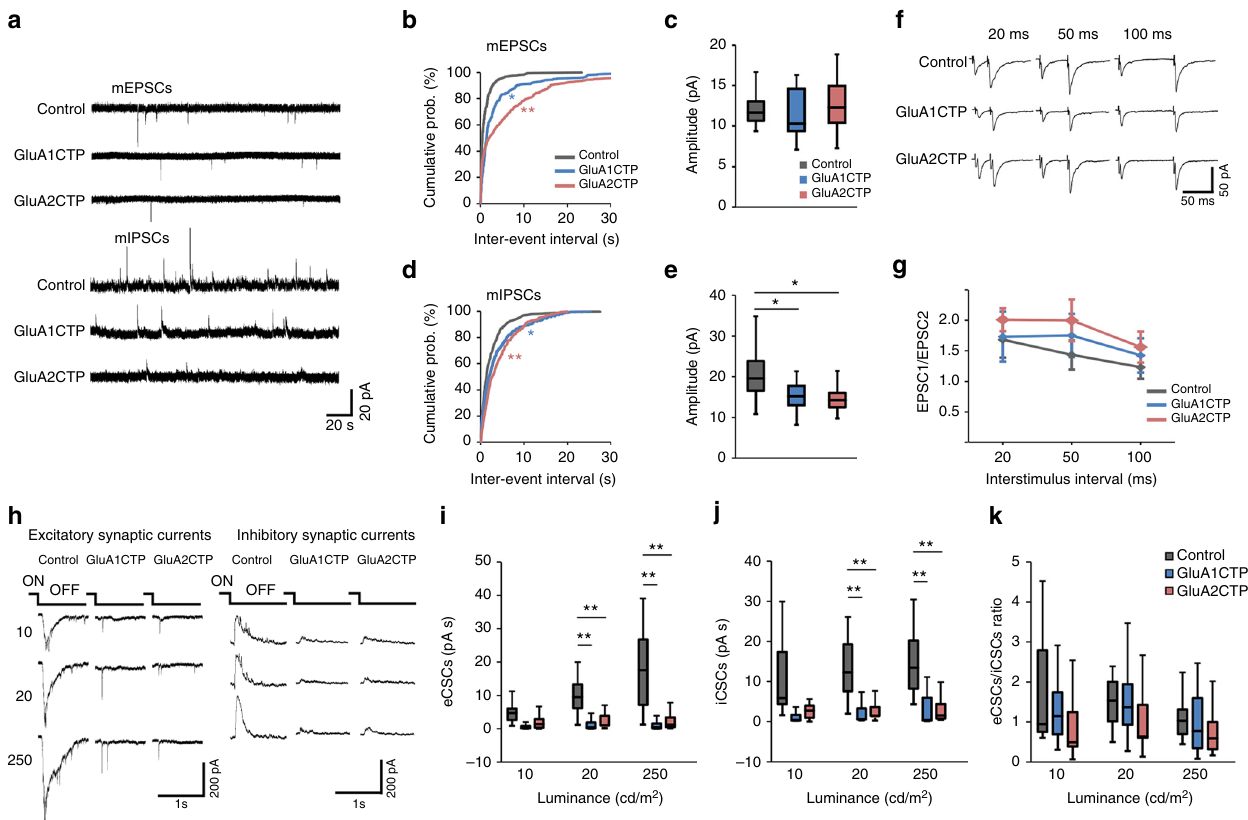
Fig. 1 GluACTP expression reduced both spontaneous and evoked excitatory and inhibitory synaptic transmission in tectal neurons. a Representative traces of mEPSCs and mIPSCs from neurons expressing EGFP only (Control), GluA1CTP, and GluA2CTP, respectively. b Expression of GluA1CTP or GluA2CTP signi fi cantly increased inter-event intervals (IEIs) of mEPSCs in tectal neurons. * P < 0.05, ** P < 0.01. Kolmogorov – Smirnov test. c Amplitudes of mEPSCs were not signi fi cantly affected by GluA1CTP or GluA2CTP expression. Control: n = 14; GluA1CTP: n = 13; GluA2CTP: n = 15. d, e Cumulative distributions ( d ) and amplitudes ( e ) of mIPSCs showing GluA1CTP or GluA2CTP expression signi fi cantly increased IEI and decreased amplitudes of mIPSCs compared to control neurons. * P < 0.05, ** P < 0.01. Kolmogorov – Smirnov test or ANOVA with Newman – Keuls posthoc test. f Representative recordings of EPSCs in response to paired stimuli 20, 50, and 100 ms apart from neurons in each experimental group. Stimulus artifact was clipped for clarity. g Paired pulse ratios of EPSC2/EPSC1 were not signi fi cantly different between control, GluA1CTP-, and GluA2CTP-expressing neurons. Scale bar: 20 pA, 20 ms. Control: n = 7; GluA1CTP: n = 5; GluA2CTP: n = 5. h Representative traces for visually evoked excitatory CSCs (eCSCs) and inhibitory CSCs (iCSCs) in control, GluA1CTP-, and GluA2CTP-expressing neurons in response to full- fi eld light off visual stimuli at intensities of 10, 20, and 250 cd cm − 2 . i , j Summary data showing that eCSCs ( i ) and iCSCs ( j ) in GluA1CTP- and GluA2CTP-expressing neurons are signi fi cantly decreased compared to control neurons in response to visual stimuli of 20 and 250 cd cm − 2 respectively. Control: n = 7; GluA1CTP: n = 7; GluA2CTP: n = 7. k The ratio of eCSCs to iCSCs in